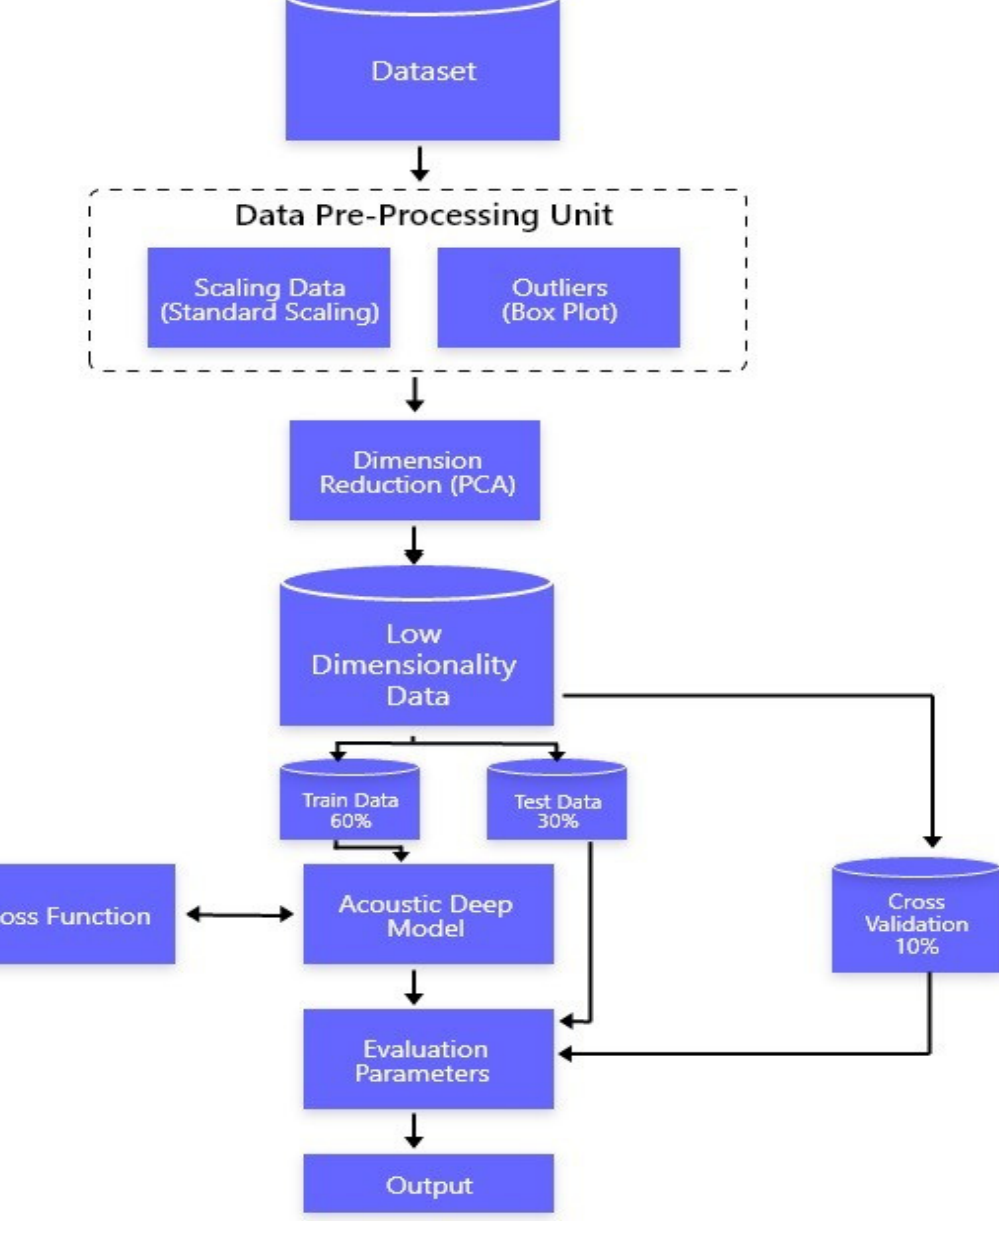
Figure 1. Proposed Figure 1. Proposed model.